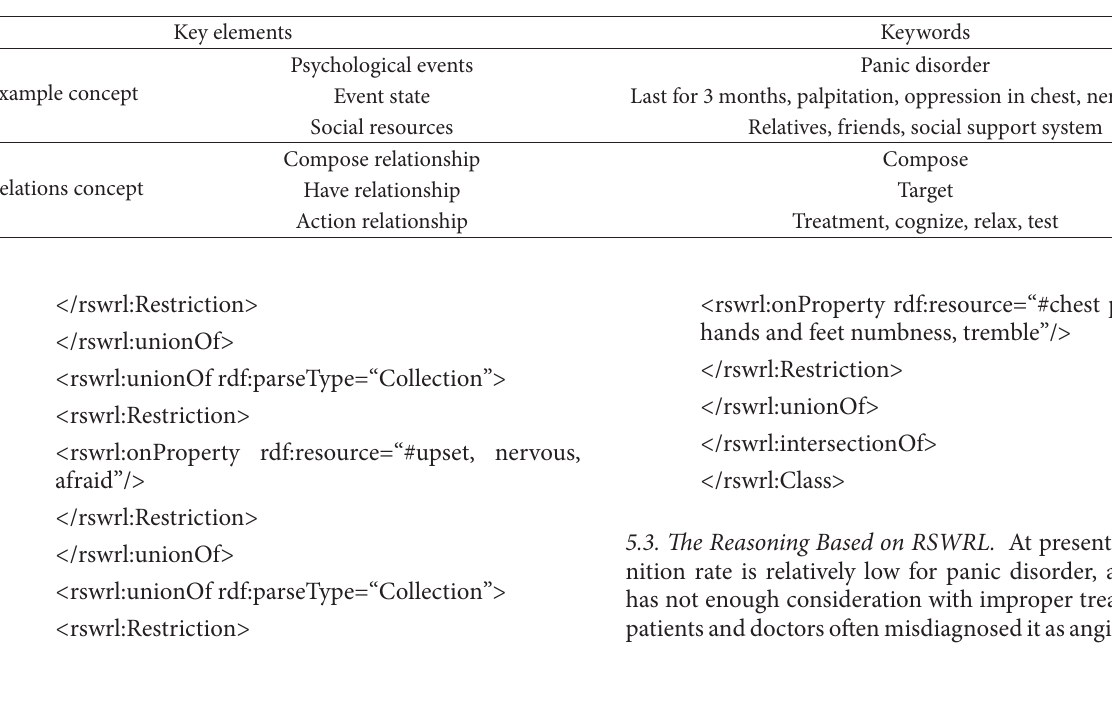
Table 1: The knowledge classification of psychological counseling